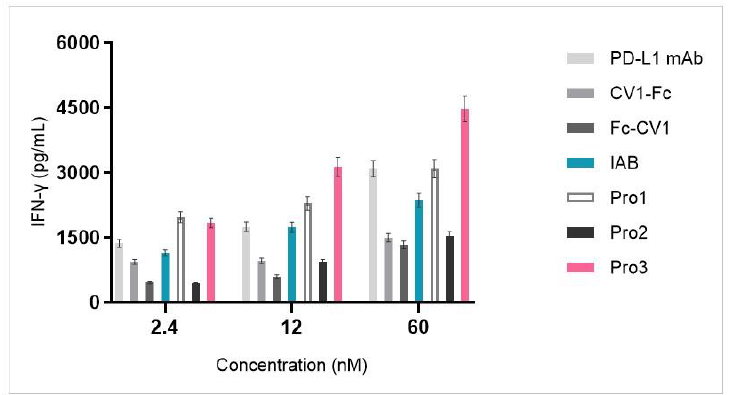
Figure 8. Dual-targeting proteins stimulated IFN- γ release from the MLR system in a dose-dependent manner.